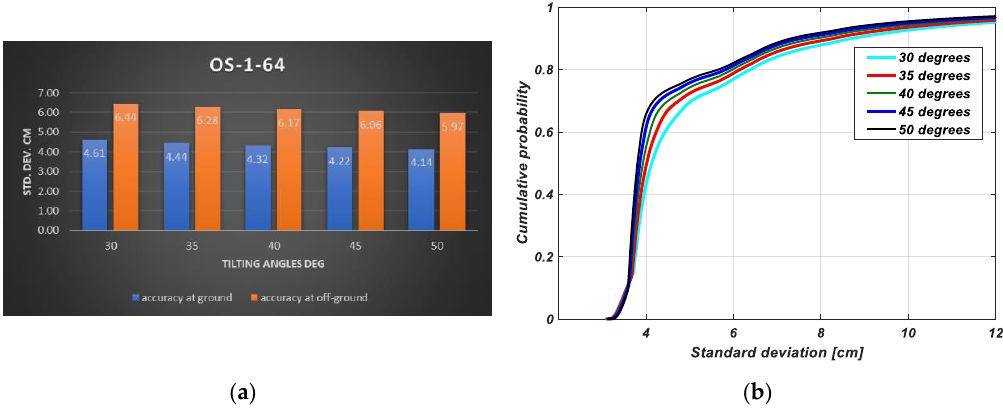
Figure 22. ( a ) Histogram illustrating the achieved relative accuracy using OS-1-64. ( b ) CDF accuracy chart.